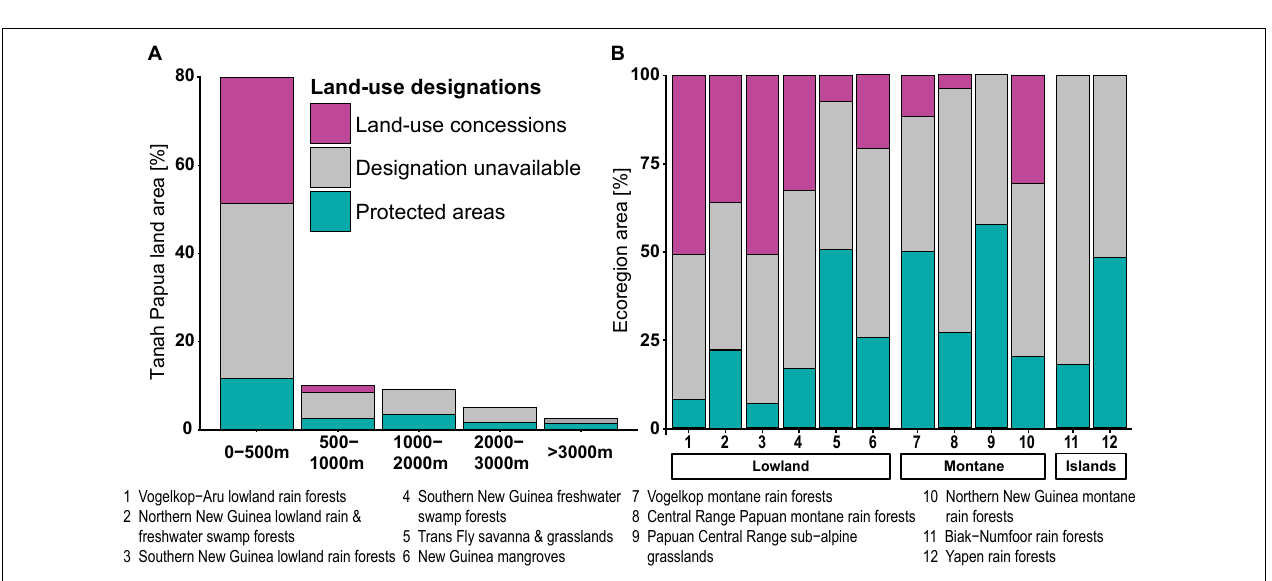
FIGURE 2 | Representation of land-use concessions and protected areas in Tanah Papua for (A) elevation and (B) existing ecoregions (Dinerstein et al., 2017). See Supplementary Figure 1 for a map of Tanah Papua’s ecoregions adapted from Dinerstein et al.